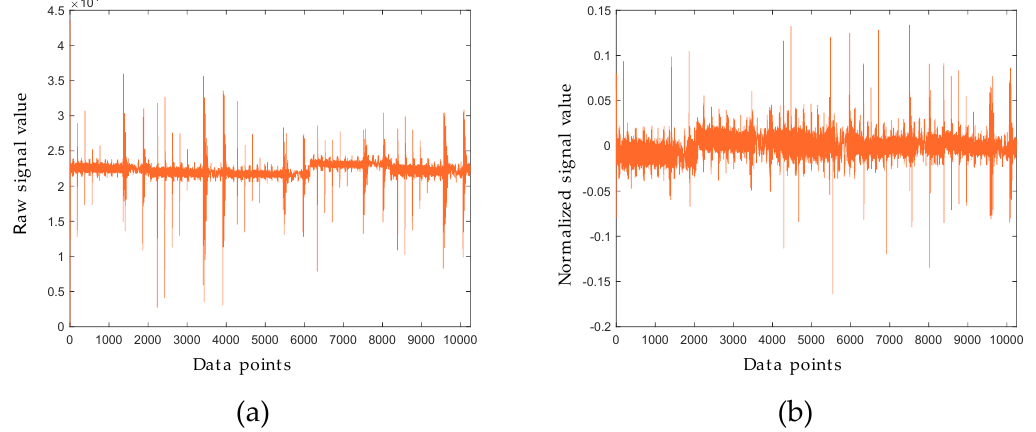
Figure 3. ( a ) Original signal versus ( b ) normalized signal by mean-centered group scaling (MCGS)